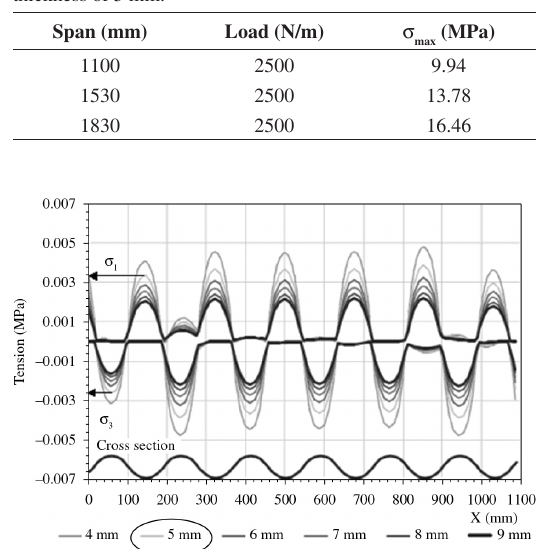
Table 5. Values for the fiber-cement corrugated sheets with thickness of 5 mm.